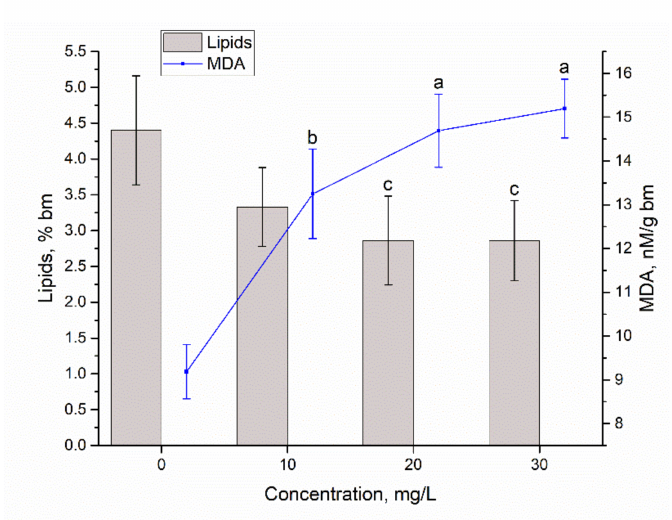
Figure 6. The content of lipids and MDA in A. platensis biomass exposed to Eu(III) in concentrations